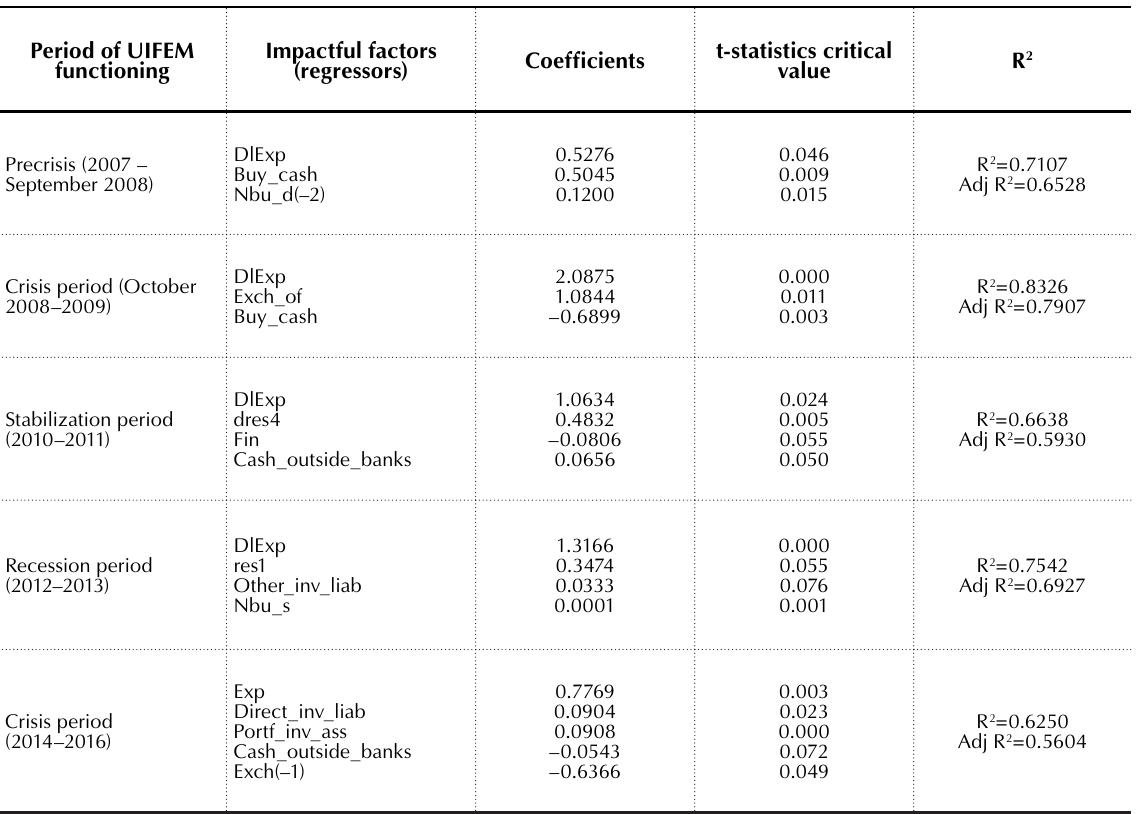
Table 5. The models of the foreign currency exchange supply at the UIFEM (non-cash segment). The foreign currency exchange supply is the dependent variable